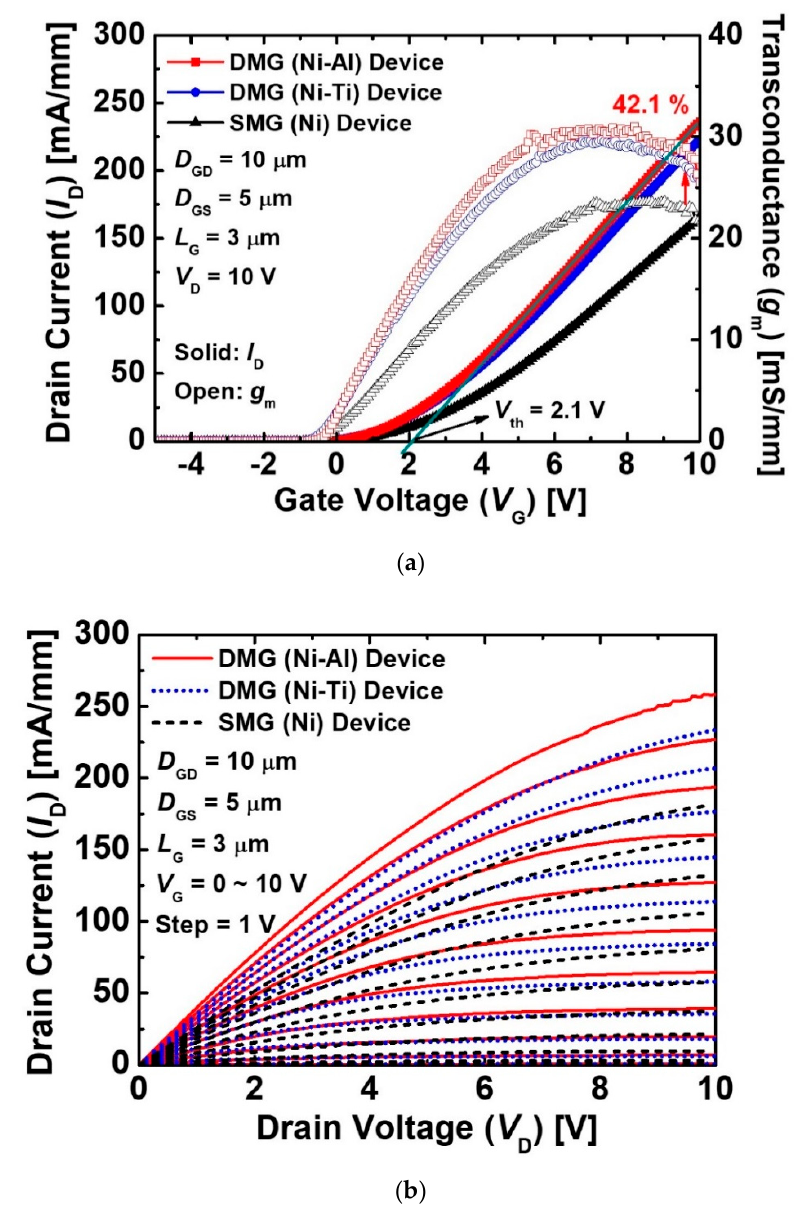
Figure 5. Effect of work-function difference in the DMG structure on current characteristics: ( a ) Transfer and ( b ) output characteristics of the devices with the SMG (Ni) and DMG (Ni-Al and Ni-Ti) structures. The L G , D GD , and D GS of the devices were 3 μ m, 10 μ m, and 5 μ m, respectively.